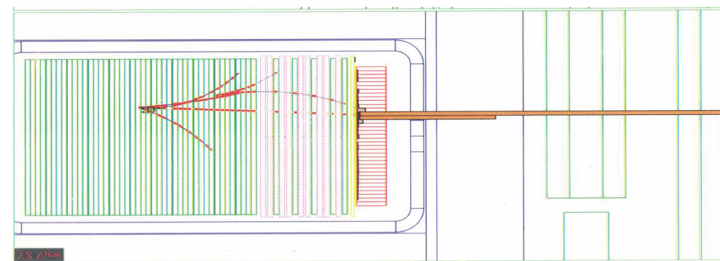
Figure 6: Candidate ] 𝑒 CC event reconstructed in the NOMAD detector.